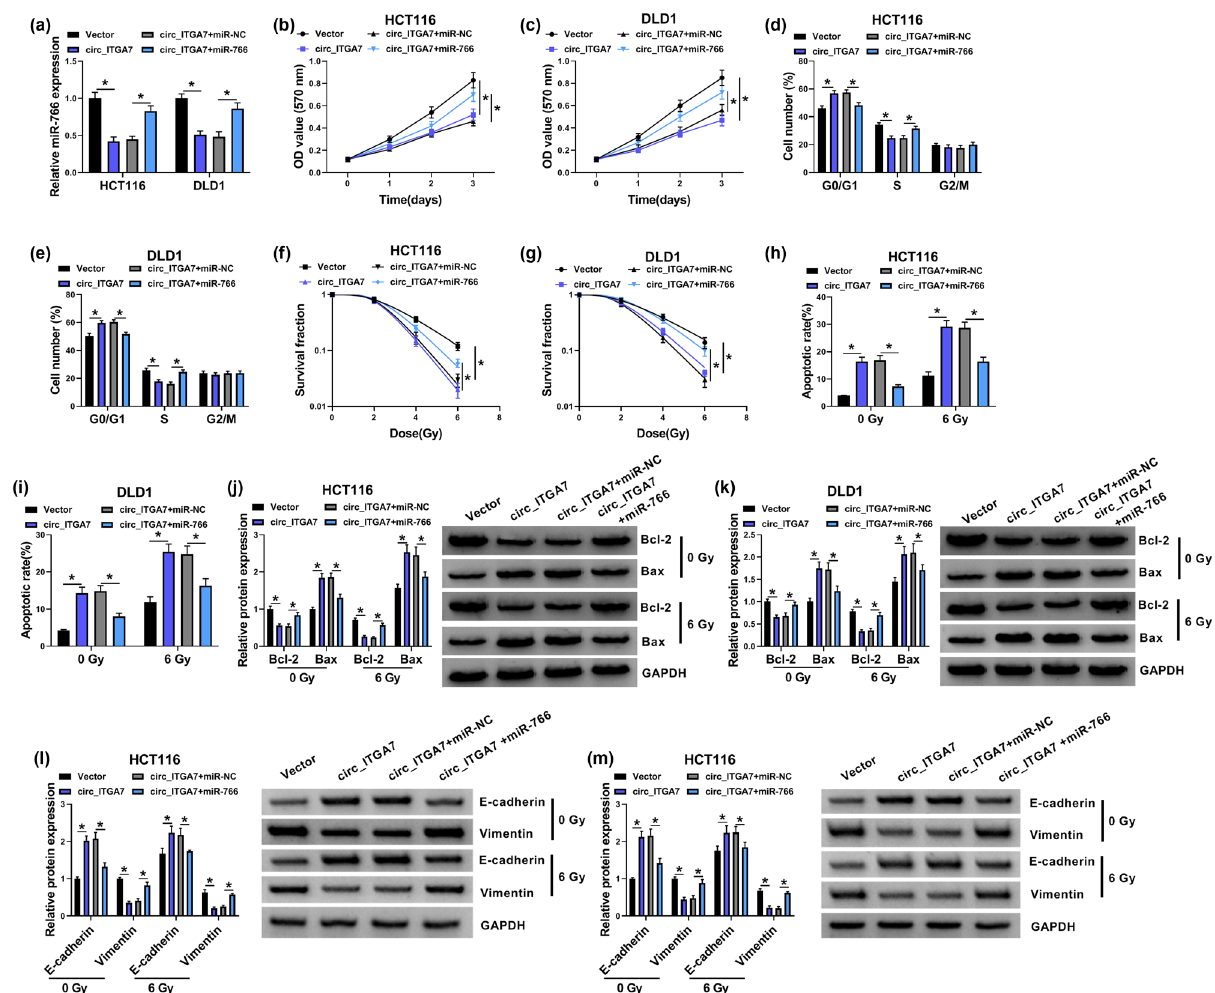
Figure 4: circ_ITGA7 suppresses cell growth and enhances radiosensitivity in CRC via regulating miR - 766. ( a – k ) HCT116 and DLD1 cells were transfected with Vector, circ_ITGA7, circ_ITGA7 + miR - NC, or circ_ITGA7 + miR - 766. ( a ) qRT - PCR analysis of miR - 766 expression in HCT116 and DLD1 cells. ( b and c ) CCK - 8 assay for the proliferation of HCT116 and DLD1 cells. ( d and e ) Flow cytometry for cell cycle distribution in HCT116 and DLD1 cells. ( f and g ) Colony formation assay for survival fraction in transfected HCT116 and DLD1 cells exposed to various doses of irradiation ( 0, 2, 4, or 6Gy ) . ( h and i ) Flow cytometry for the apoptosis of transfected HCT116 and DLD1 cells exposed to 0 or 6Gy irradiation. ( j – m ) Detection of Bax, Bcl - 2, E - cadherin, and Vimentin protein levels in transfected HCT116 and DLD1 cells exposed to 0 or 6Gy irradiation using western blot. * P <